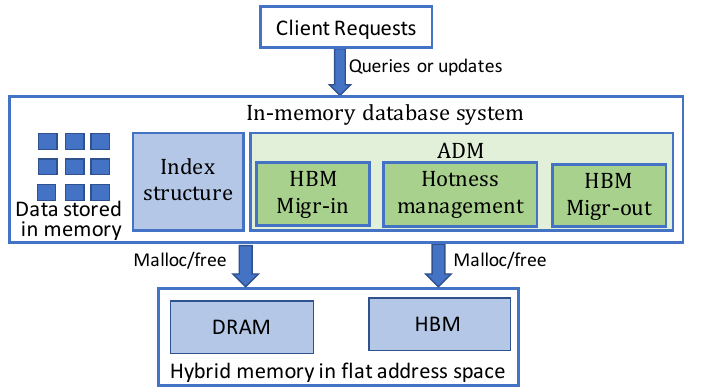
Figure 2. Overview of the proposed ADM method. ADM contains three components and is integrated to the Redis in-memory